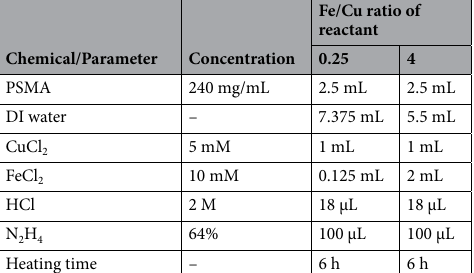
Table 2. The formula of CuFe oxide-polymer NPs synthesis.